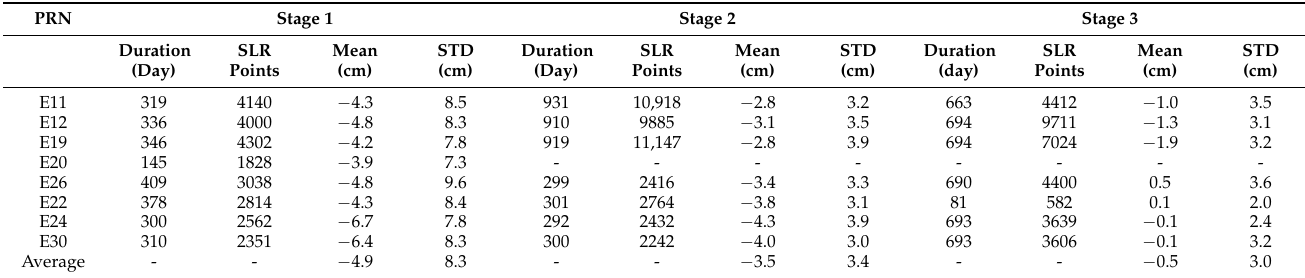
Table 8. Statistical information for SLR residuals calculated from WUM orbits.